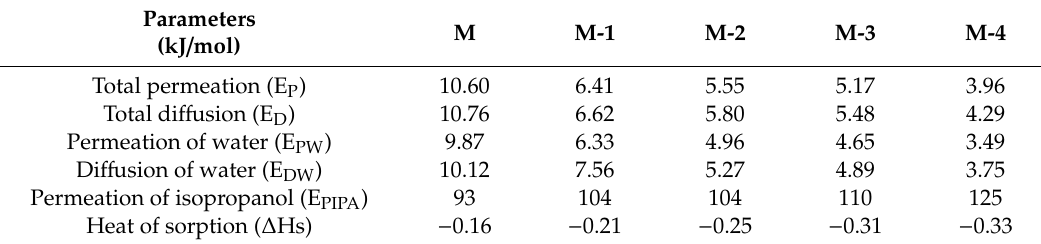
Table 5. Arrhenius activation parameters for permeation and di ff usion, and heat of sorption.